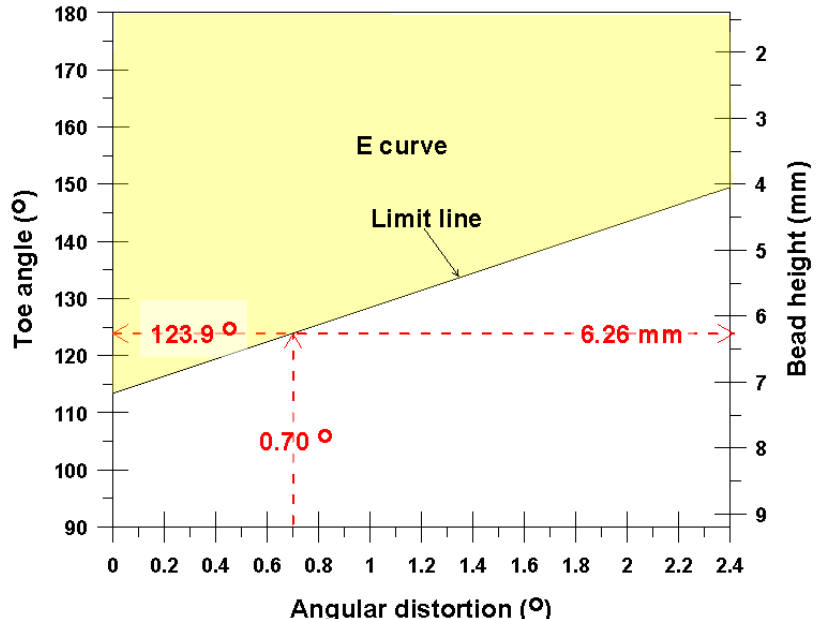
Figure 24. Toe angle and weld bead height satisfying the E curve requirements of the BV rule.